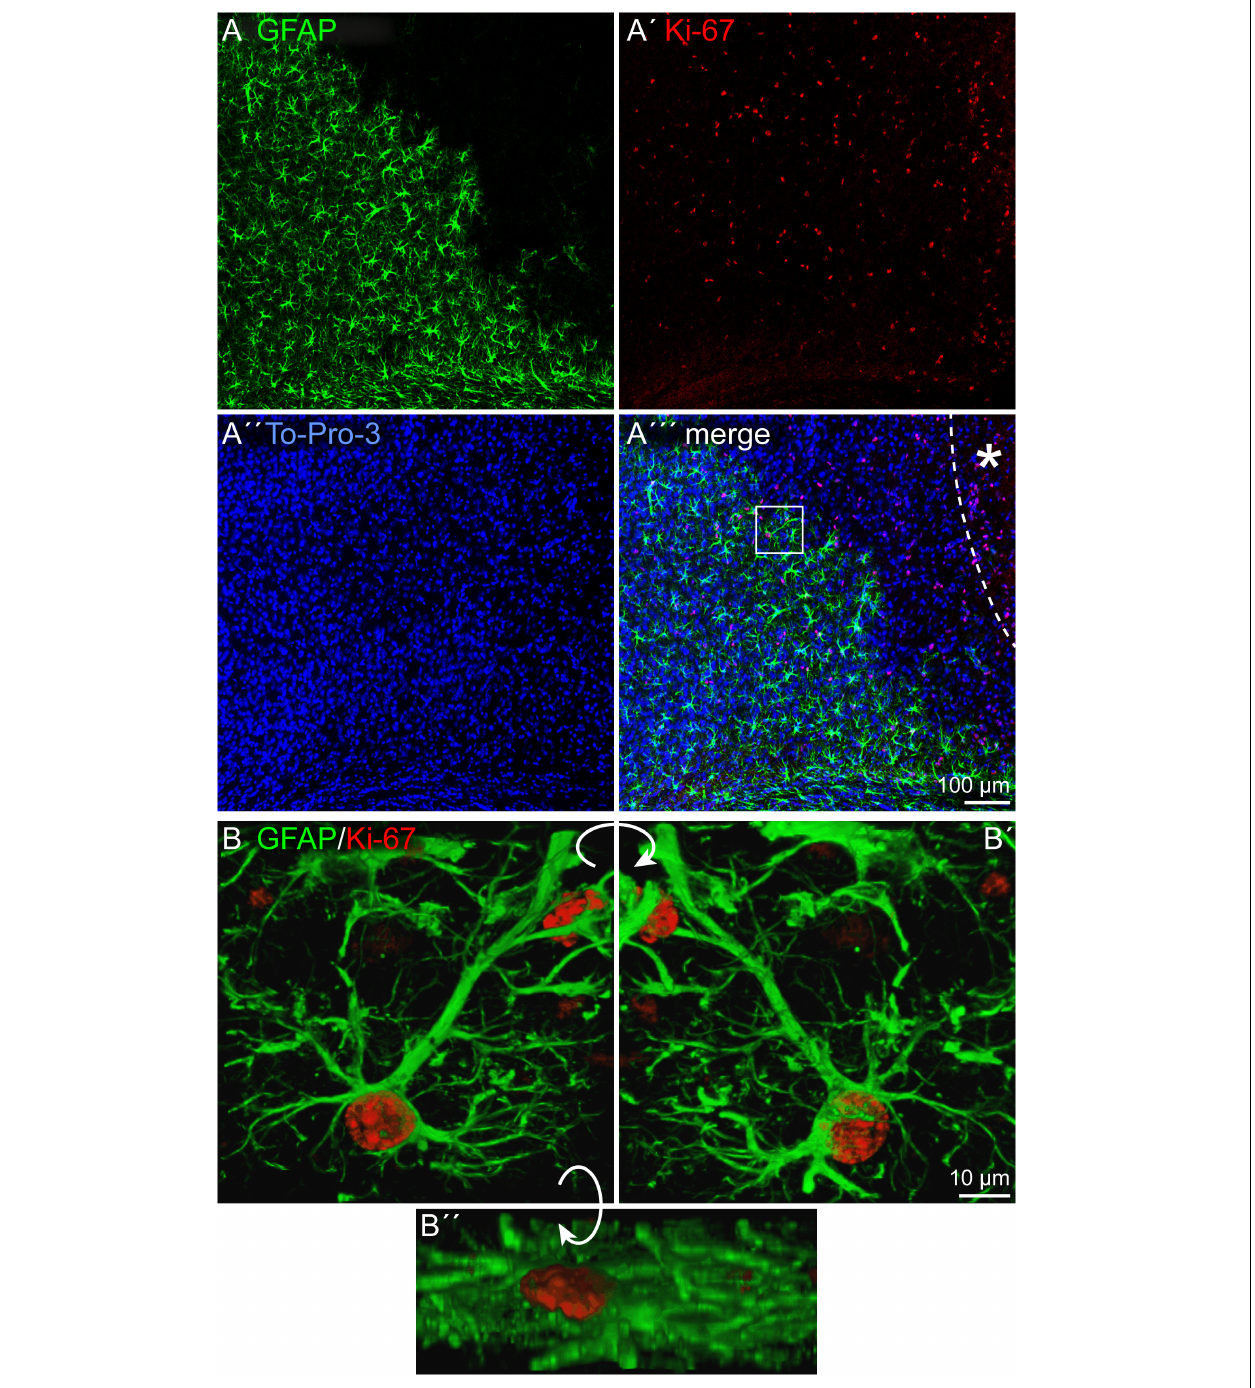
FIGURE 5 | Proliferation of reactive astrocytes, 3 dpl. (A–A (cid:48)(cid:48)(cid:48) ) Immunohistochemical stainings for Ki-67 labeled numerous proliferating cells in the penumbra after lesion. Some of these cells were also GFAP-positive. (B–B (cid:48)(cid:48) ) An example of a proliferating astrocyte (boxed in A (cid:48)(cid:48)(cid:48) ) is shown after three-dimensional reconstruction of confocal images. Asterisk: direction toward the lesion core; scale bars: 100 µ m (A–A (cid:48)(cid:48)(cid:48) ) , 10 µ m (B–B (cid:48)(cid:48) ) .